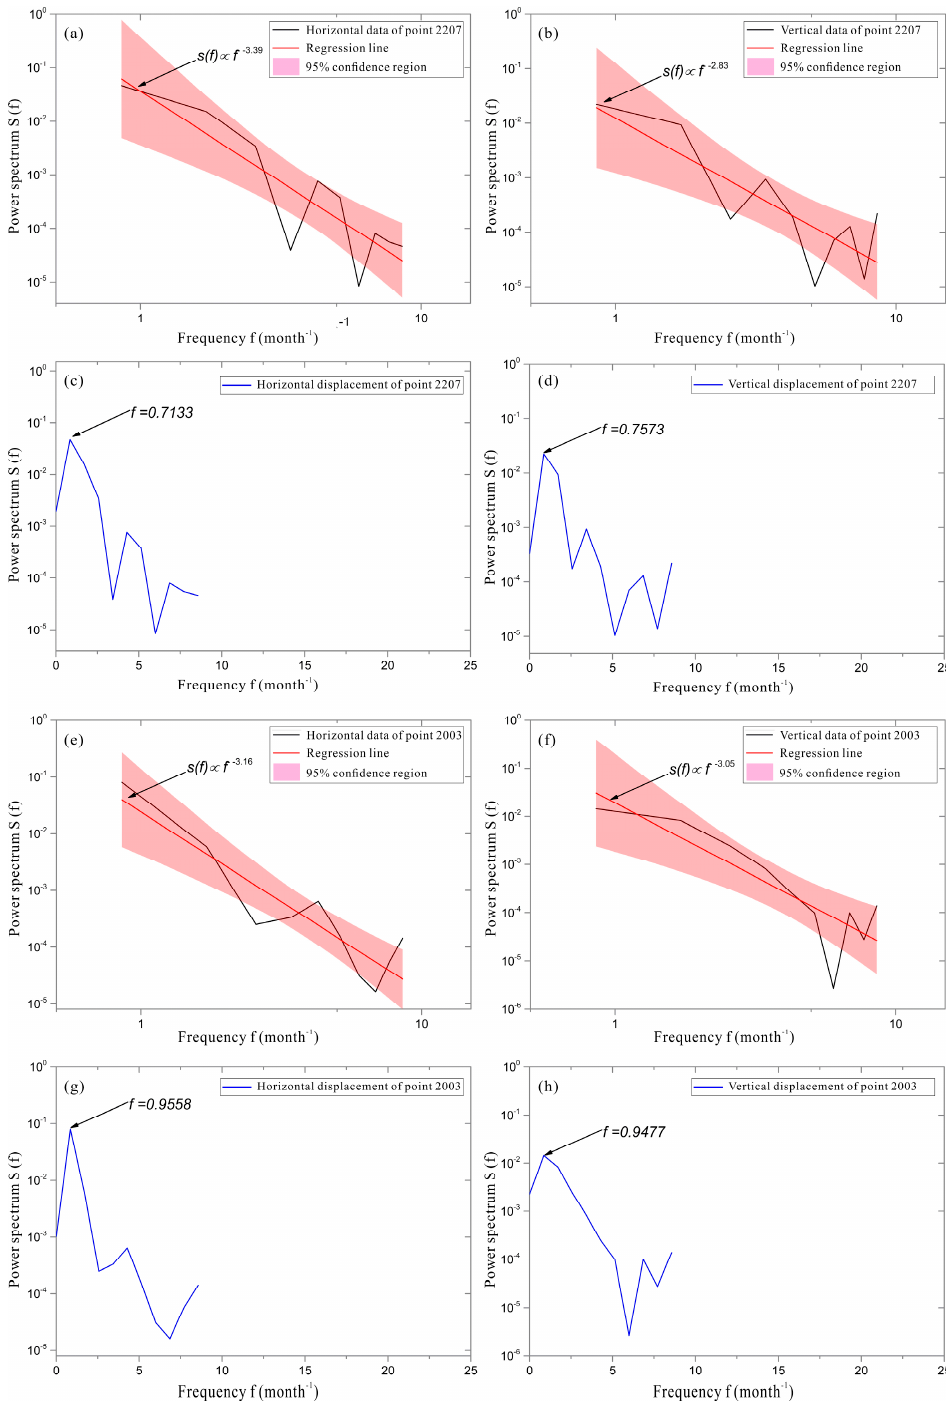
Figure 6. Power spectra of the horizontal and vertical displacement in the monitoring point 2207 at minefield No.2 and the monitoring point 2003 at minefield No.1 in log S(f) –log (f) and log S(f) – f plots: ( a , b ): power spectra of the horizontal and vertical displacement of the monitoring point 2207 in a log S(f) –log (f) plot; ( c , d ): power spectra of the horizontal and vertical displacement of the monitoring point 2207 in a log S(f) – f plot; ( e , f ): power spectra of the horizontal and vertical displacement of the monitoring point 2003 in a log S(f) –log (f) plot; ( g , h ): power spectra of the horizontal and vertical displacement of the monitoring point 2003 in a log S(f) – f plot.